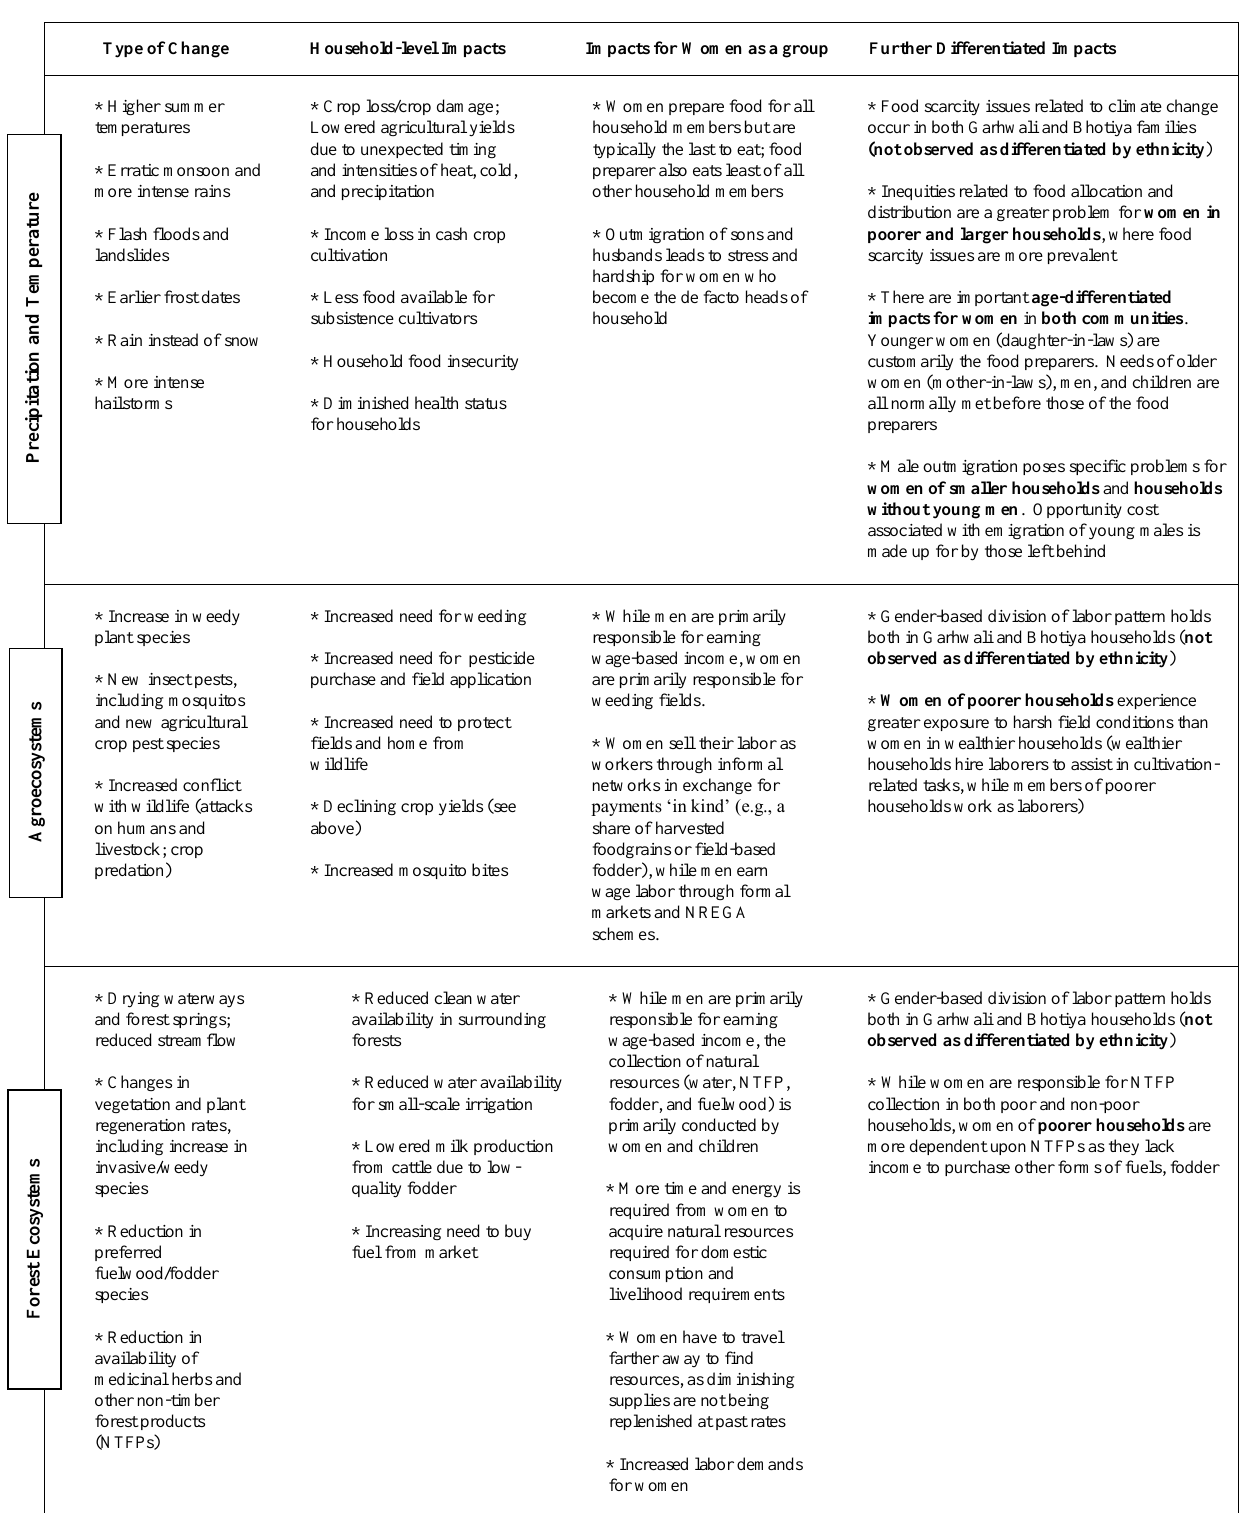
Figure 2. Climate change indicators and impacts for NDBR